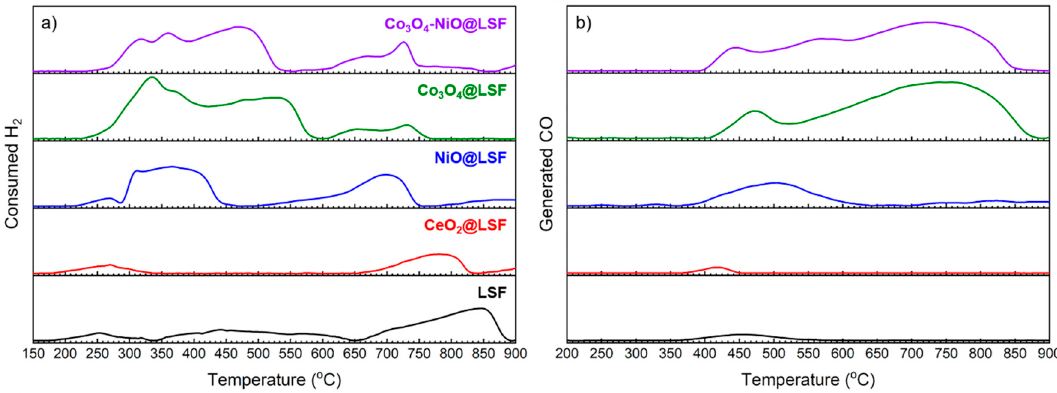
Figure 6. Results of H 2 -TPR ( a ) and CO 2 -TPO ( b ) measurements.